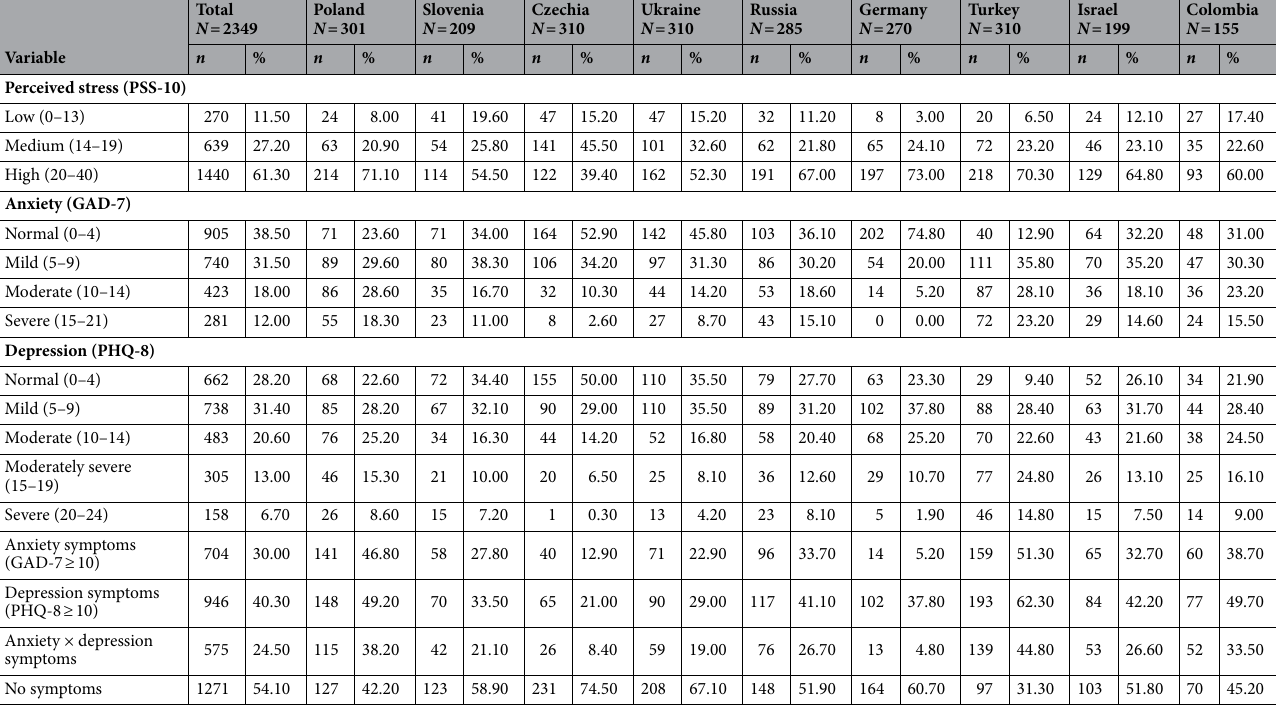
Table 3. Prevalence of perceived stress (PSS-10), anxiety (GAD-7), and depression (PHQ-8) among students in nine